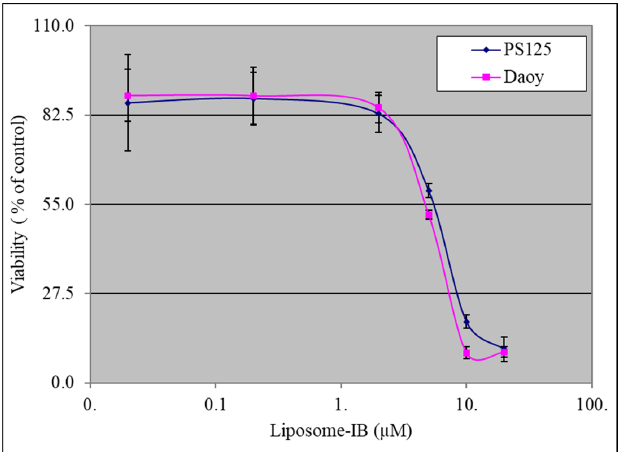
Figure 1. Lipo-IB inhibits sonic hedgehog (SHH) medulloblastoma cell growth. IC50 values of SmoA1 murine PS125 and human Daoy cells were calculated based on MTT assay. The data represent the mean (± standard deviation, SD) of three independent experiments, each performed in triplicate.